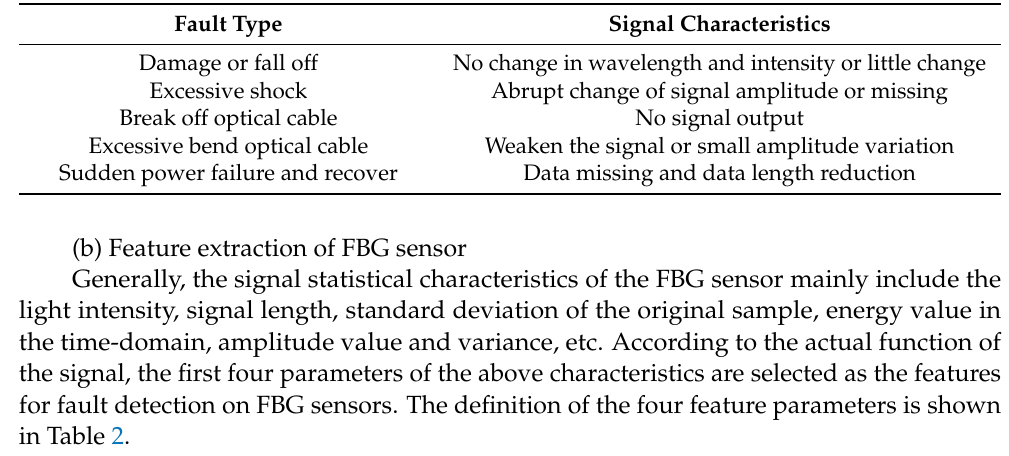
Table 1. Features values and synthetical abnormal index of five faulty FBG